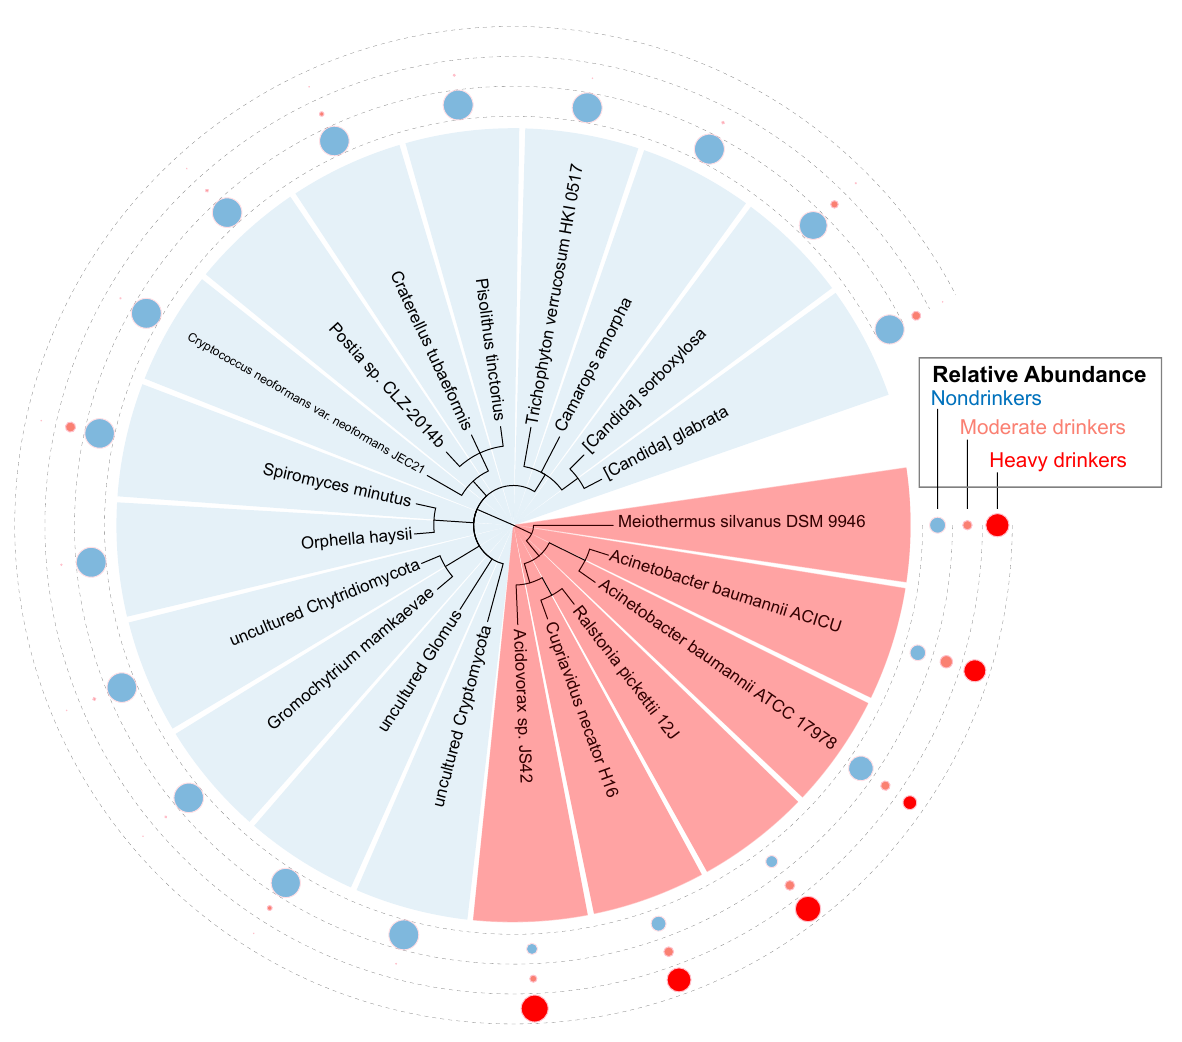
Figure 7. Differential abundance of microbes associated with HPV- heavy drinkers, moderate drinkers, and nondrinkers. Differential abundance analysis was conducted to identify those signifi- cantly dysregulated microbes specific to heavy drinkers, moderate drinkers, and nondrinkers. We classified nondrinkers as 0 drinks a day, moderate drinkers as one drink a day, and heavy drinkers as two or more drinks a day. All red species on the phylogenetic tree are classified as bacteria, while the blue species are classified as fungi. Dysregulation of microbial species in association with alcohol consumption habits is represented by the smaller circles surrounding the phylogenetic tree. These smaller circles are organized by cohort: dark red represents heavy drinkers, light red represents moderate drinkers, and light blue represents nondrinkers. If the size of the circle is relatively large, the microbial species is upregulated in that particular cohort. If the size of the circle is relatively small, the microbial species is downregulated in that particular